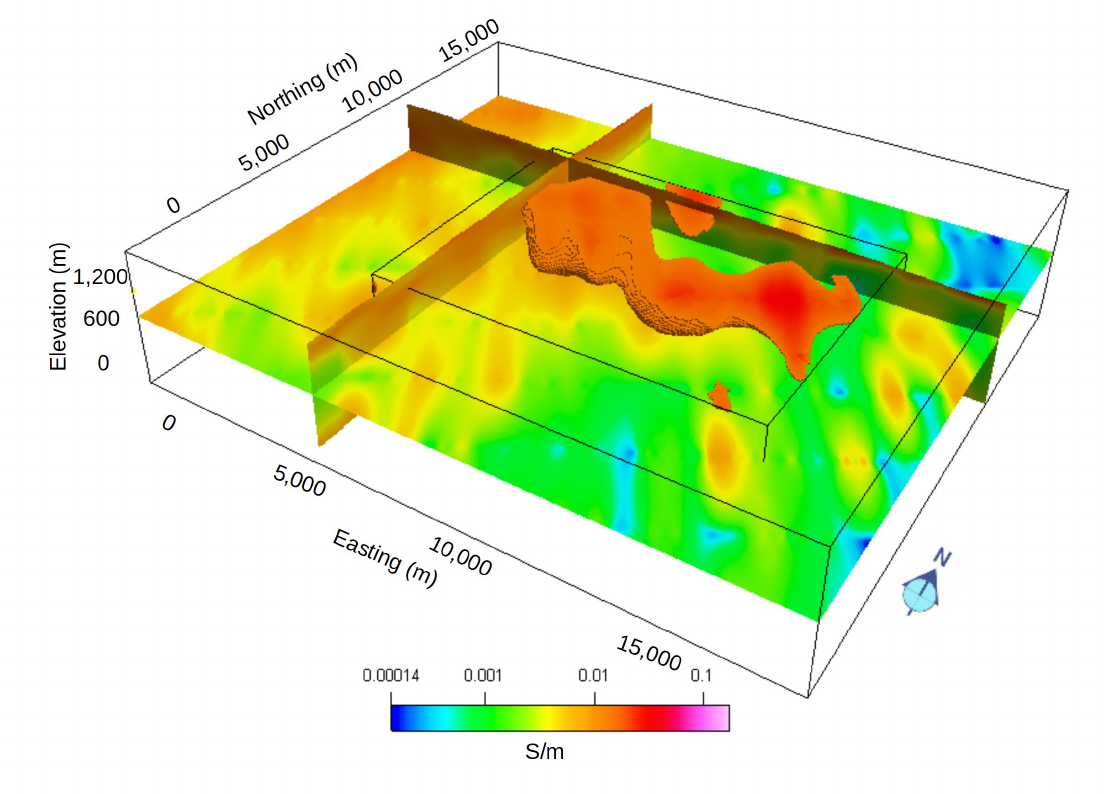
Figure 10. 3D view of a local conductivity anomaly. Voxels with conductivities greater than 100 mS/m are shown, as are cross sections of